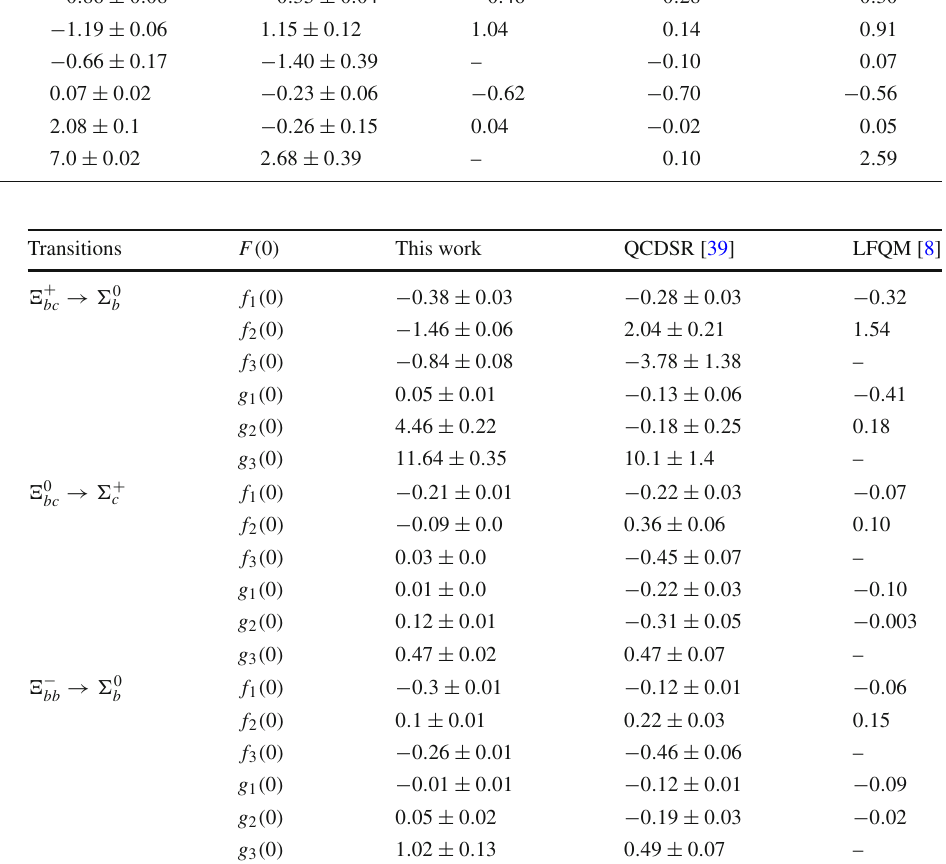
Table 6 Comparison of (cid:2) cc decay form factors derived in this work with the results from QCD sum rules (QCDSR) [39], light-front quark model (LFQM) [8], the non-relativistic quark model (NRQM) and the MIT bag model (MBM) [48] Transitions F ( 0 ) This work QCDSR [39] LFQM [8]